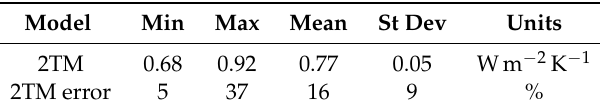
Table 4. Minimum, maximum, mean, and standard deviation of U -value and relative systematic measurement error estimates for the CWall_E, using the 2TM model and hypothetical monitoring campaigns of different